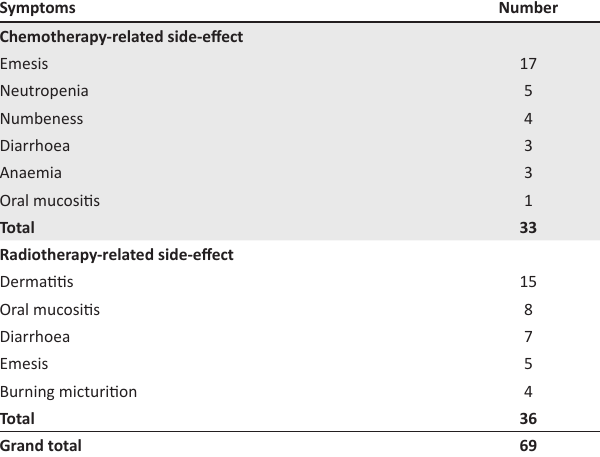
TABLE 2: Most common presenting complaint of cancer patients prompting unplanned visits to the outpatient unit at the National Cancer Institute, Sudan. Chief complaints